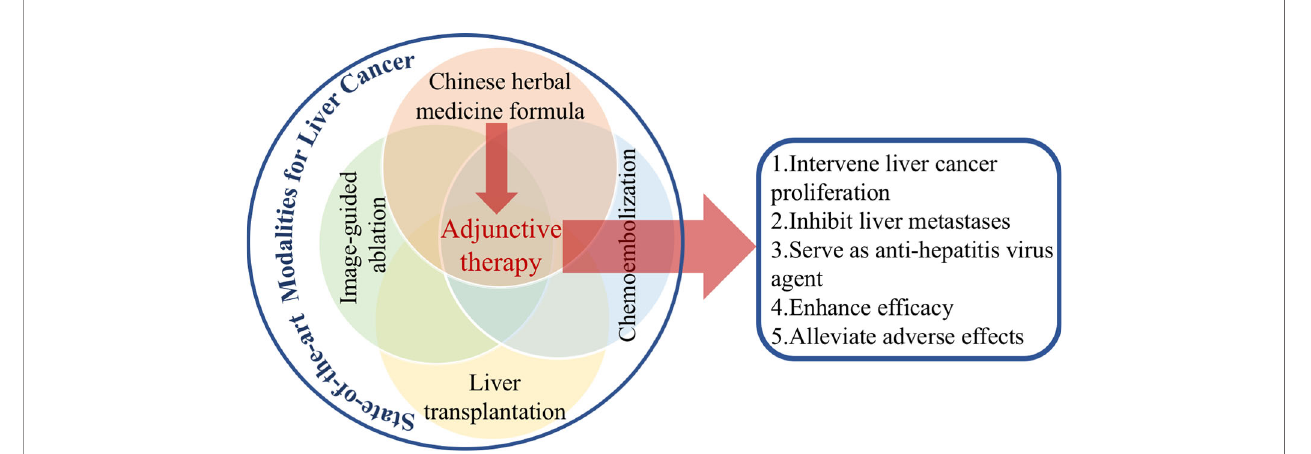
FIGURE 1 | The roles of Chinese herbal medicine formulas in liver cancer